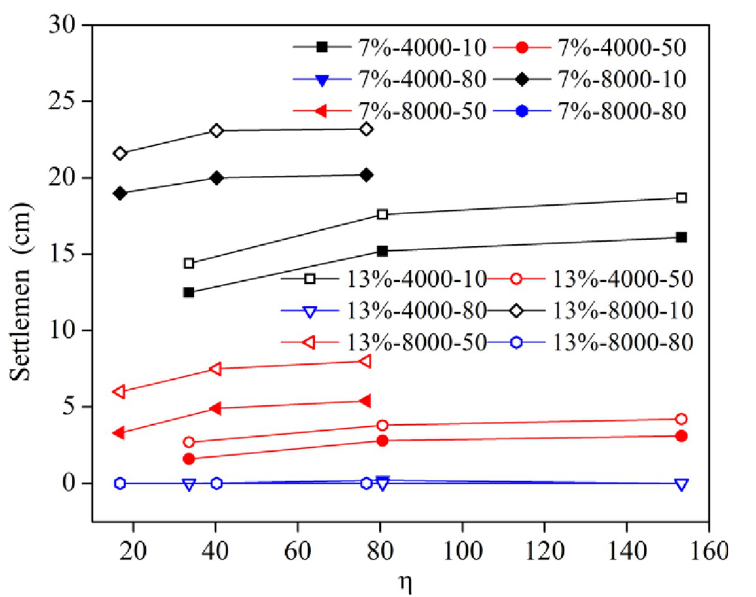
Fig 11. Change curves of the layer settlement verses the η value.